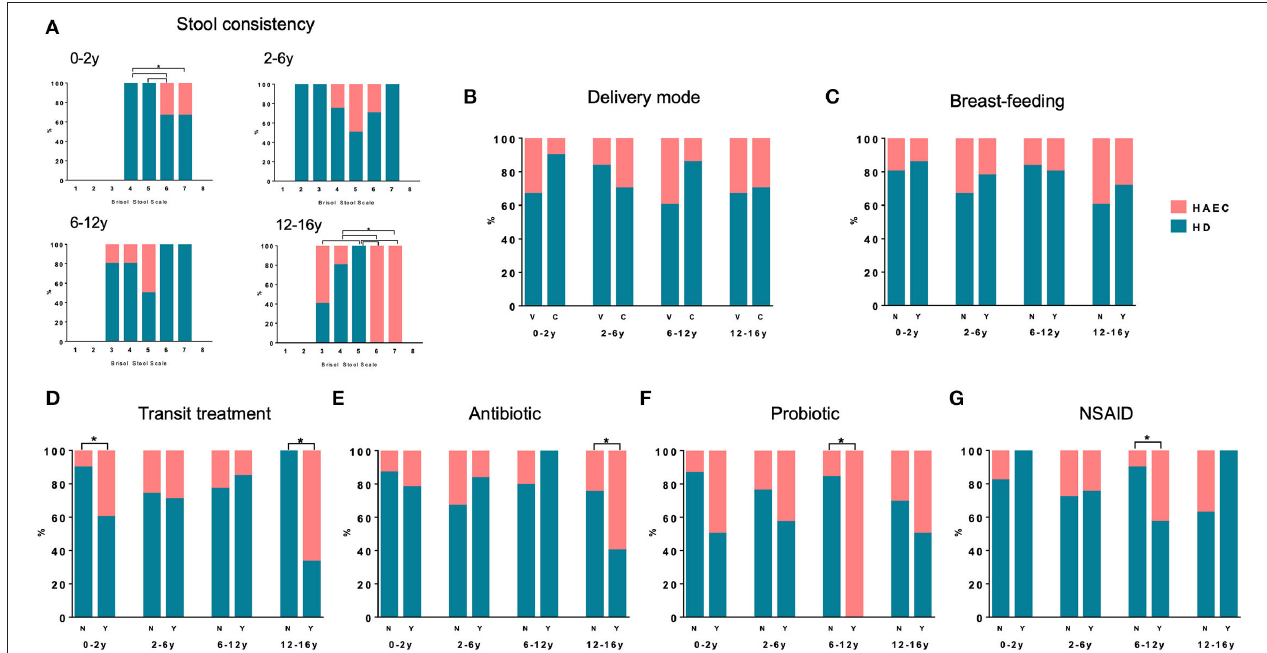
FIGURE 2 | Hirschsprung-associated enterocolitis incidence and factors known to modulate gut microbiota. Hirschsprung-associated enterocolitis incidence as a function of stool consistency (A) , delivery mode (B) , breast-feeding (C) , treatment for transit (D) , antibiotic within the last 6 months (E) , probiotic treatment (F) or non-steroidal anti-inflammatory drug (NSAID) (G) in the different age groups. * P < 0.05 for Hirschsprung-associated enterocolitis